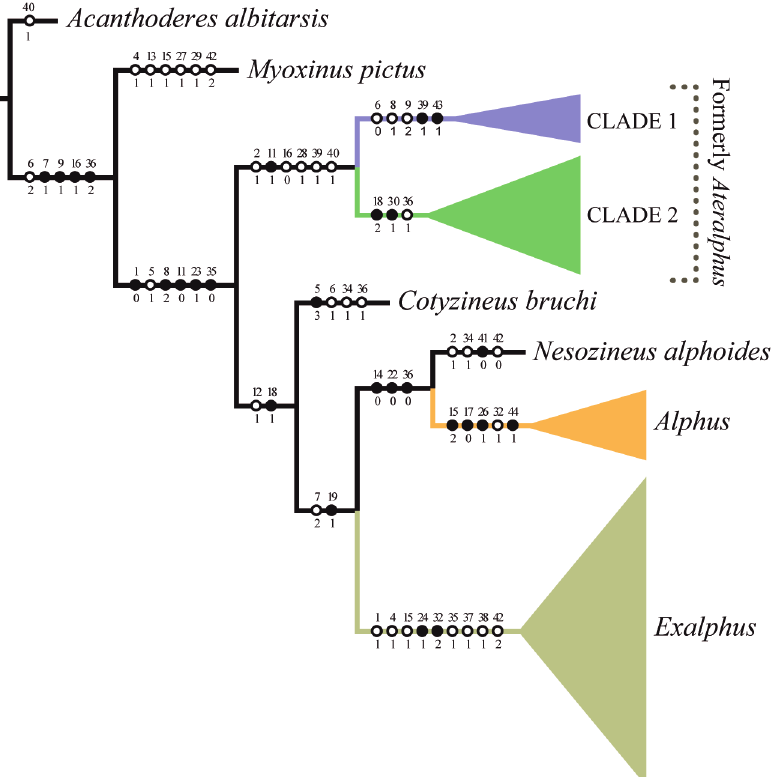
Figure 17. Summarized topology obtained from the cladistics analysis of Ateralphus and related genera Alphus and Exalphus , showing all character state transformations under ACCTRAN optimization. CLADE 1: Grandateralphus gen. n.; CLADE 2: Current Ateralphus